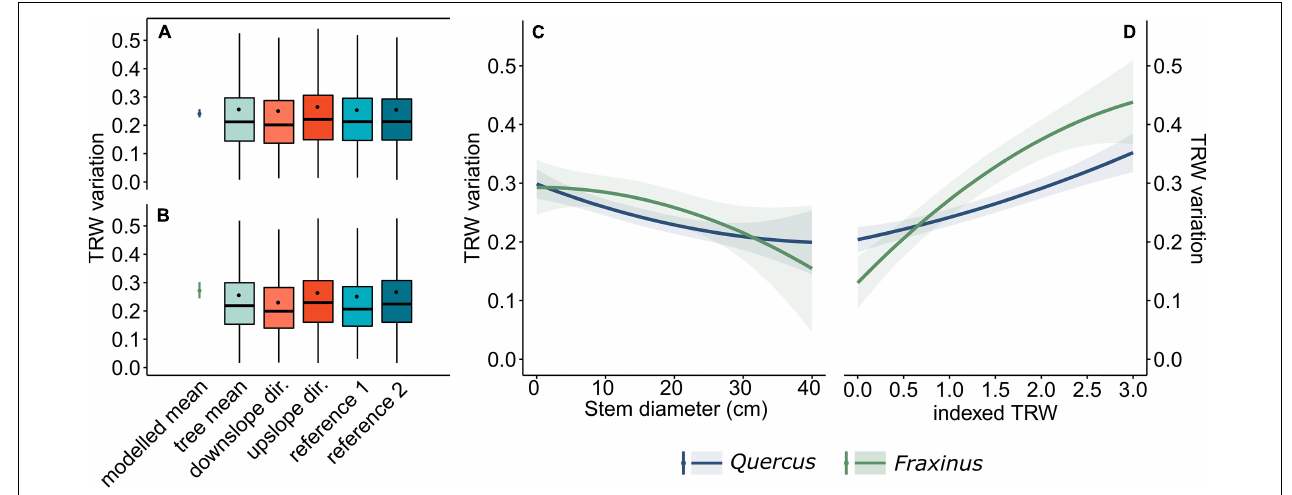
FIGURE 2 | Modeled and observed stem diameter variation of Quercus (A) and Fraxinus (B) , the modeled effect of stem diameter on tree-ring width (TRW) variation (C) and the modeled effect of indexed TRW on TRW variation (D) . The boxplots represent 25th and 75th percentiles, thick horizontal lines represent medians and dots represent the mean values. Whiskers denote the 1.58*inter-quartile range (ggplot2), while outliers are not